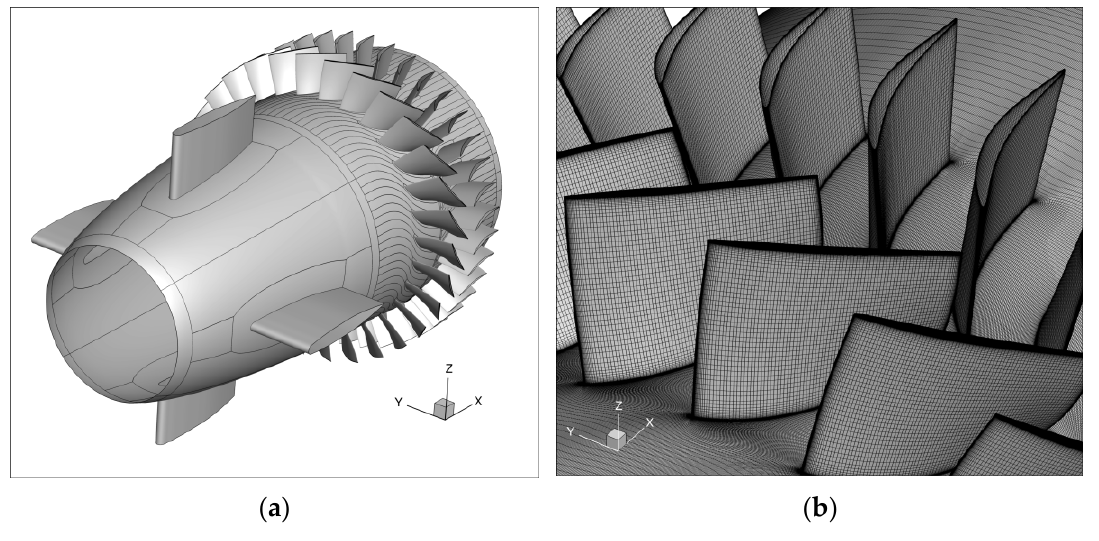
Figure 3. ( a ) CFD domain; ( b ) grid views.